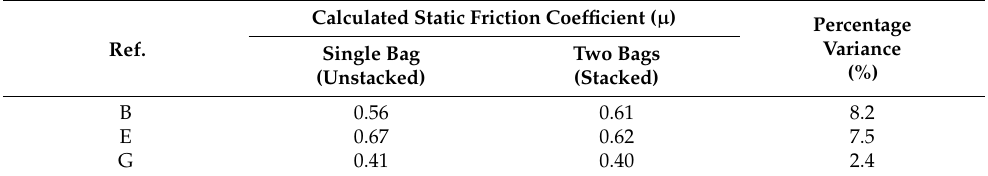
Table 6. Percentage variance between stacked and unstacked test data.